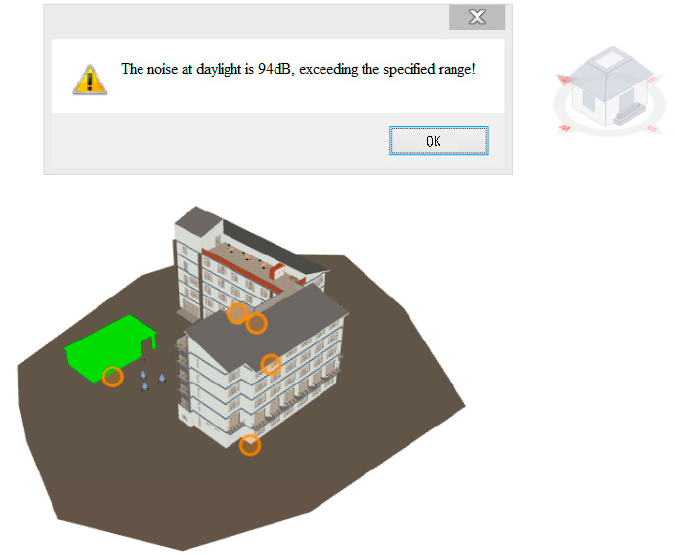
Figure 20. The overrun alarm for noise values.